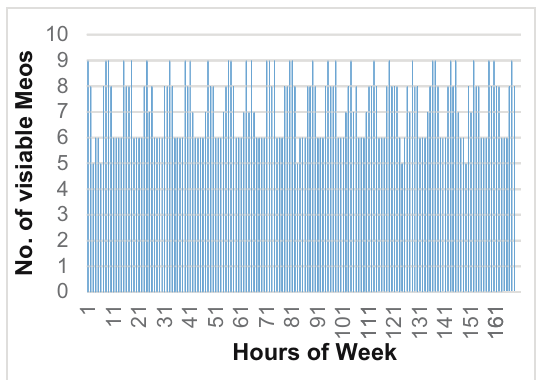
Figure 2: The number of visible MEO satellites in the Weinan